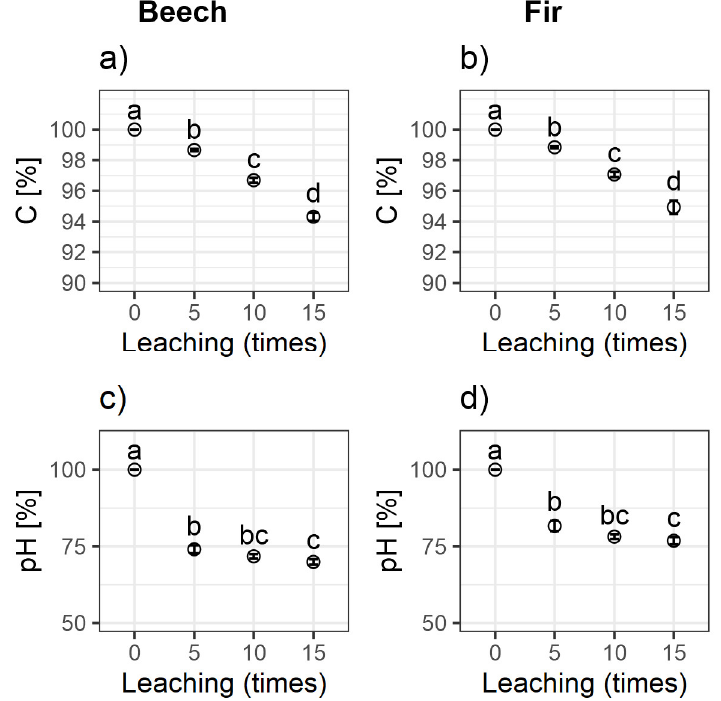
Figure 2. Comparison of percentage changes in the ( a ) carbon content and ( c ) pH of soils under beech stands and the ( b ) carbon content and ( d ) pH of soils under fir stands as a result of leaching (0 (non-leached), 5, 10, and 15 times).